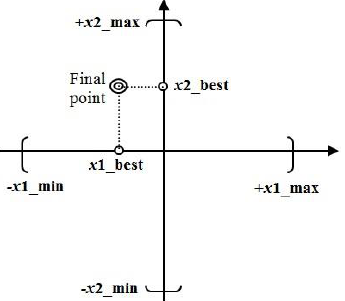
Figure 1. Illustration of Coordinate Exhaustive Search